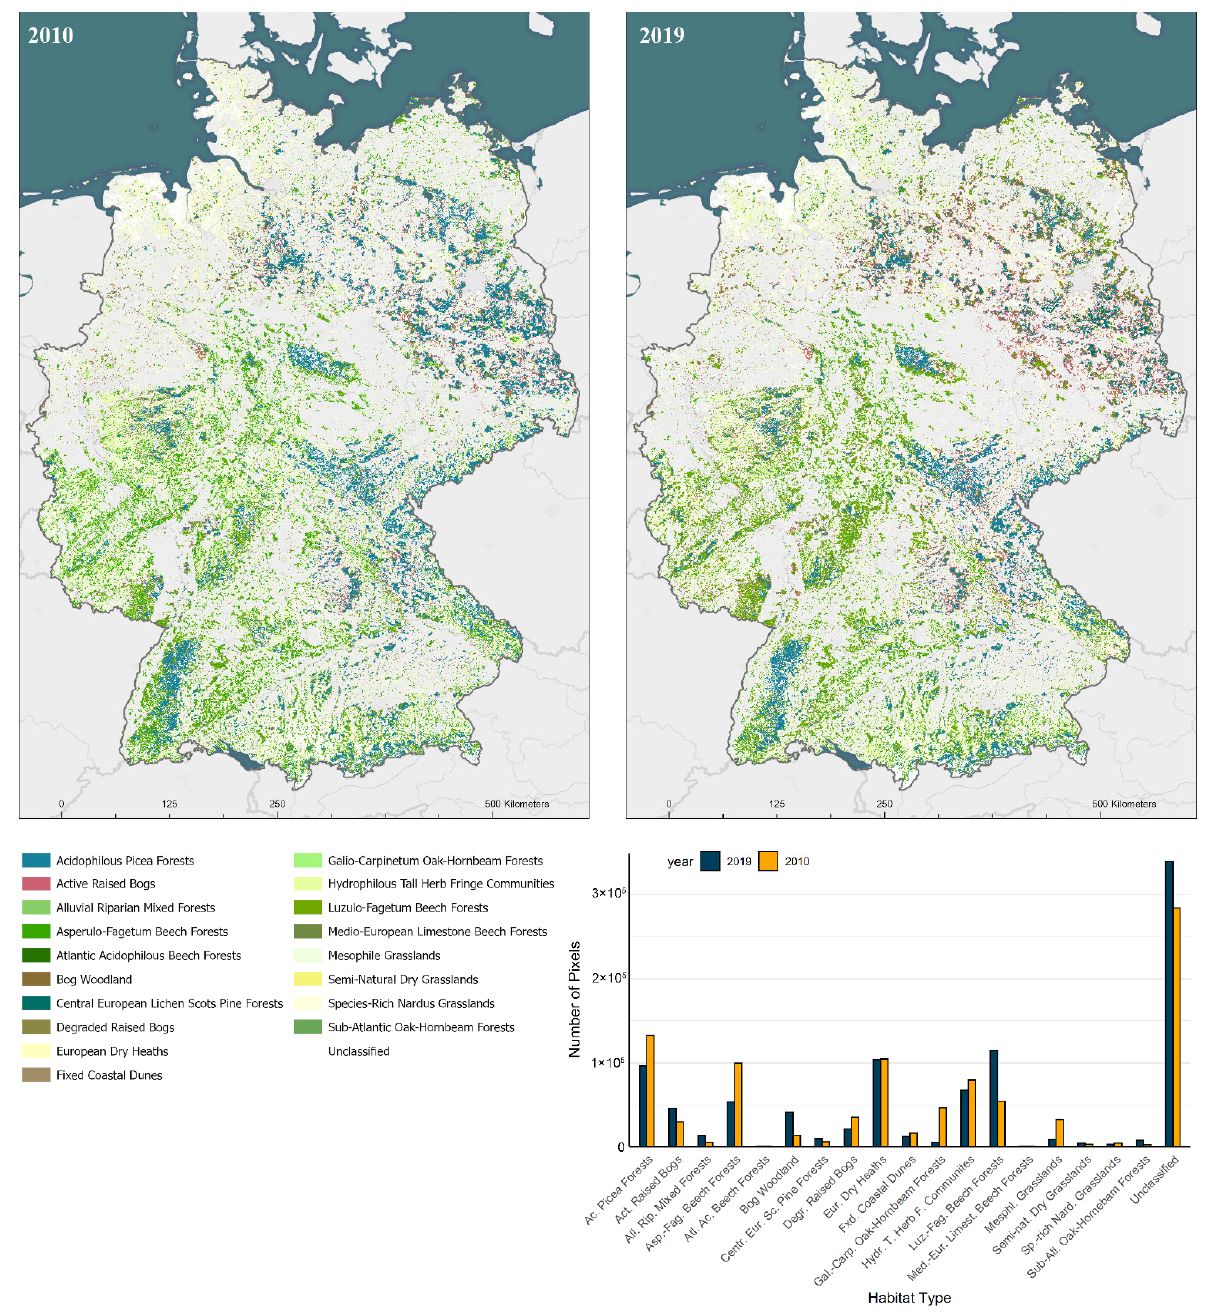
Figure 5. Final results of the habitat classification for Germany in 2010 and 2019. Each pixel was assigned a final prediction based on the ensemble of nine models for each year. The change in the number of pixels per habitat type between 2010 and 2019 is shown at the bottom right.